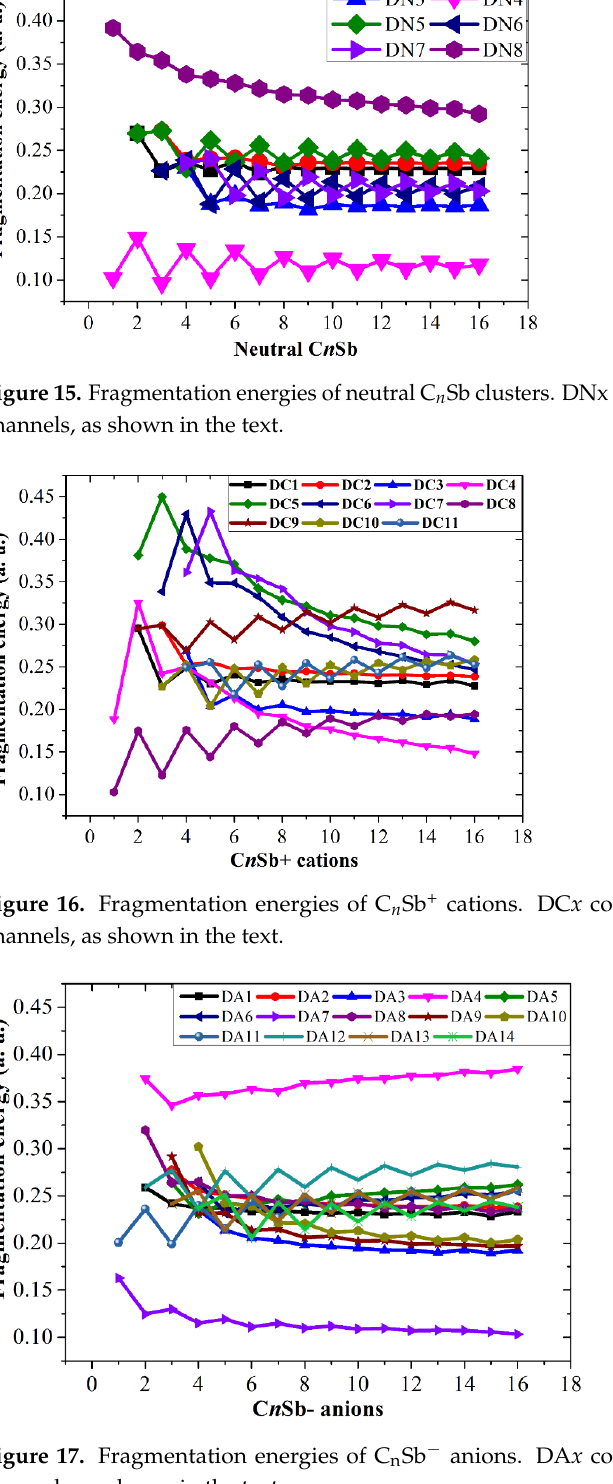
Figure 18. The most favorable dissociation channels for C n Sb/ C n Sb + / C n Sb − . For carbon chain clusters, the most favorable binding site of atomic antimony is the terminal carbon of the carbon cluster because the terminal carbon with a large spin den- sity bonds in an unsaturated way. We have constructed initial structures with antimony binding on nonterminal carbon and found that the optimization of these structures often encounters a convergence problem or loop back to the linear structure with antimony binding to the terminal carbon. For the structures which encounter convergence prob- lems or converge to geometry with antimony binding on nonterminal carbon, we further optimized them and obtained the local minima (Figure 19). For antimony binding on C 2 , the 2a nonlinear structure showed a C-C distance of 1.315 Å , longer than the linear structure. The results indicate that the construction of the nonlinear shape C n Sb can fur- ther activate the C-C bond. Nonlinear C 3 Sb and C 4 Sb show C 2V symmetric structures. The C-C bonds of C 3 Sb are all 1.335 Å , while the C-C bond adjacent to antimony shows a substantially longer distance of 1.380 Å . Nonlinear C 5 Sb with antimony binding on the